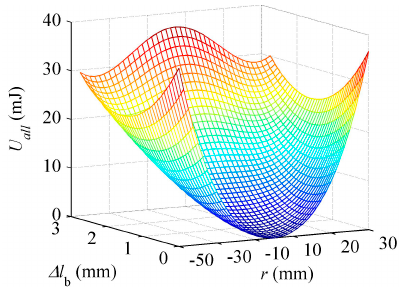
Figure 3. Variation in total elastic energy as a function of tip displacements with preloading.